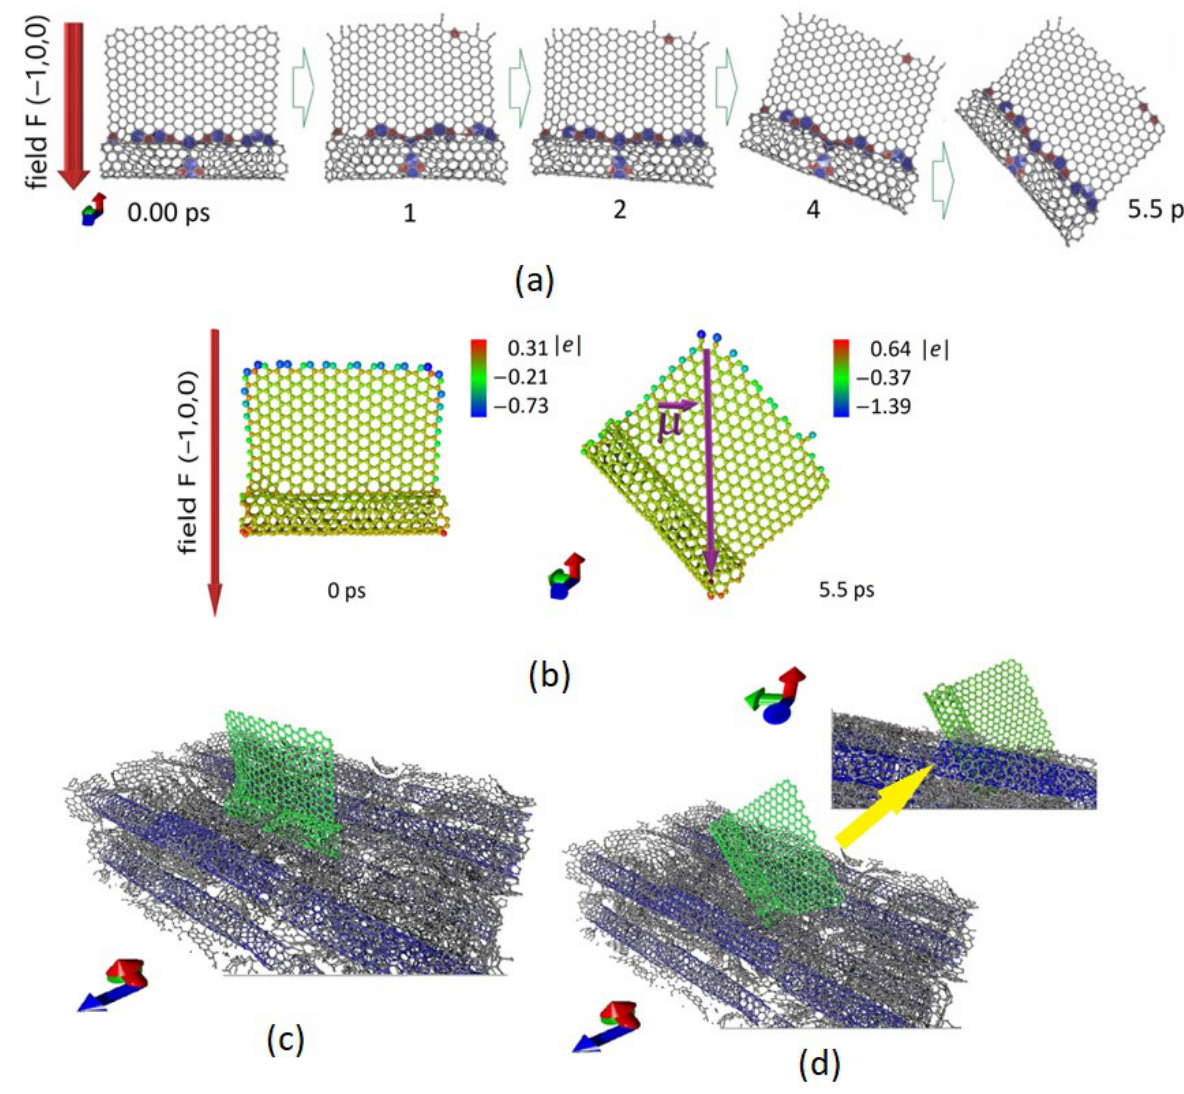
Figure 5. ( a , b ) Response of a hybrid based on a graphene flake bonded to SWCNT to an external electric field over time; a fragment of the layer surface of hybrids based on graphene flakes bonded to SWCNT, ( c ) before, and ( d ) after laser exposure.